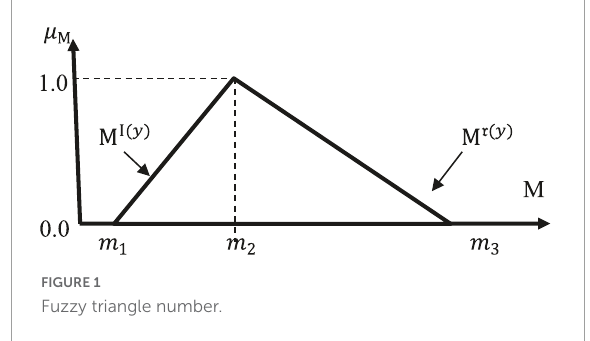
FIGURE1 Fuzzy triangle number.